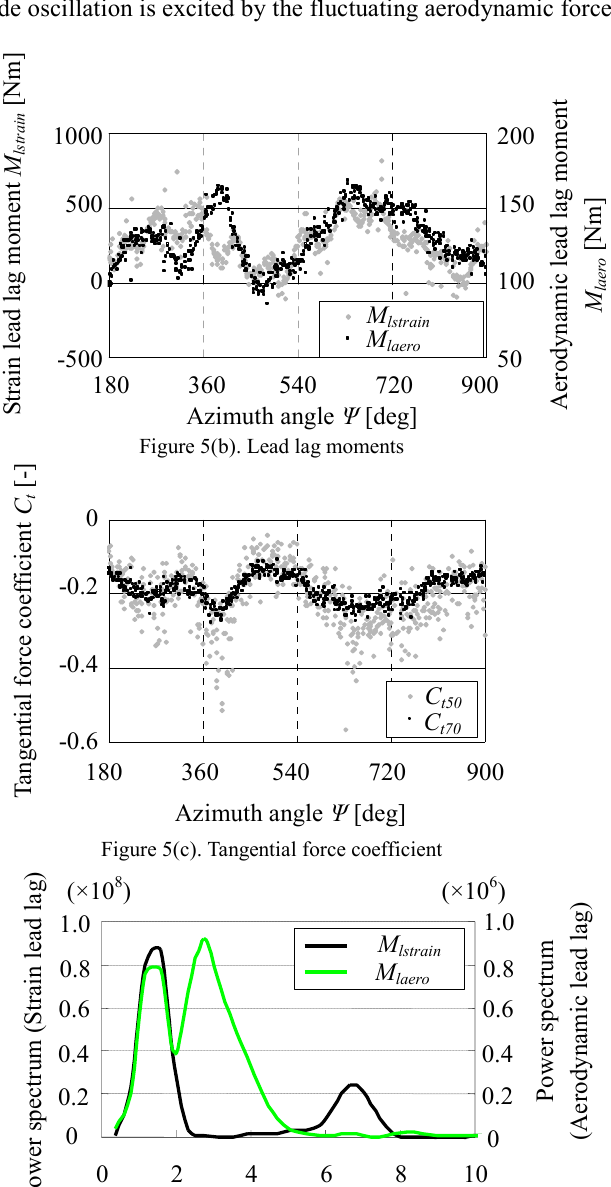
Figure 5(d). Power spectrum of lead-lag